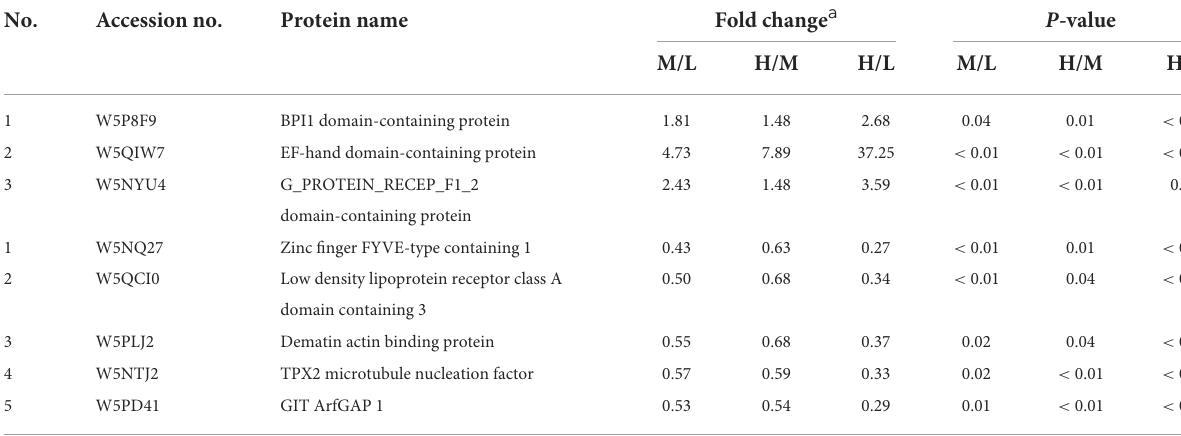
TABLE 4 The consistently up-regulated and down-regulated MFGM proteins with dietary protein level.